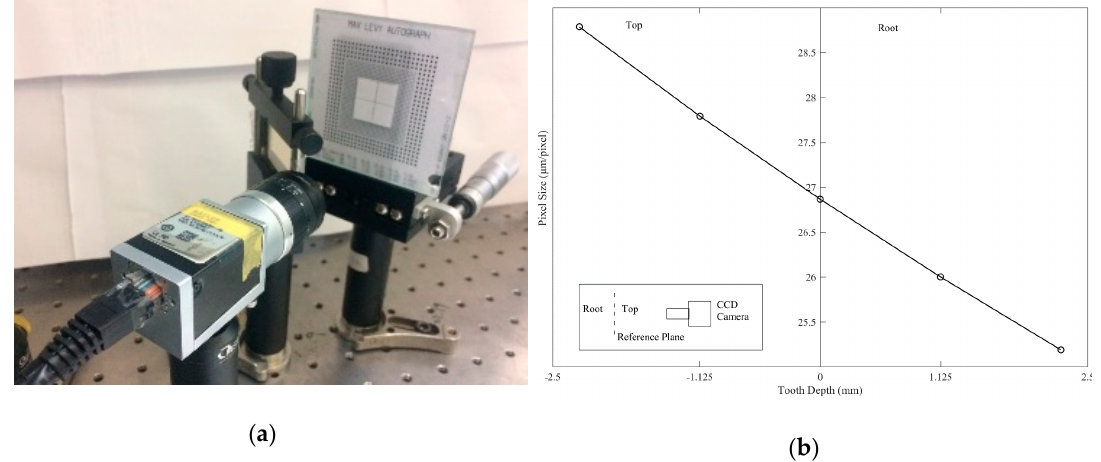
Figure 6. ( a ) Distortion coefficient correction with a grid distortion target; ( b ) calibration coefficient of the magnification along the tooth depth.